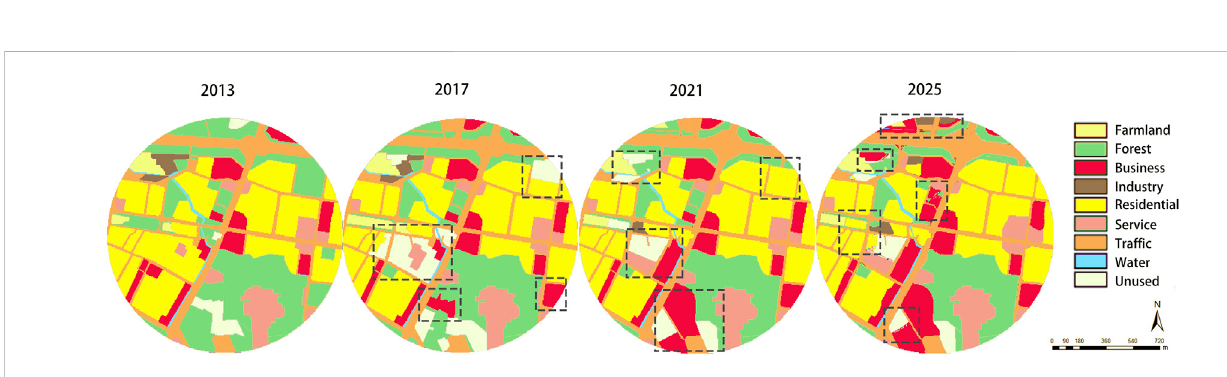
FIGURE 4 Land use maps of 2013, 2017, 2021 and predicted land use maps of 2025 at Zoo